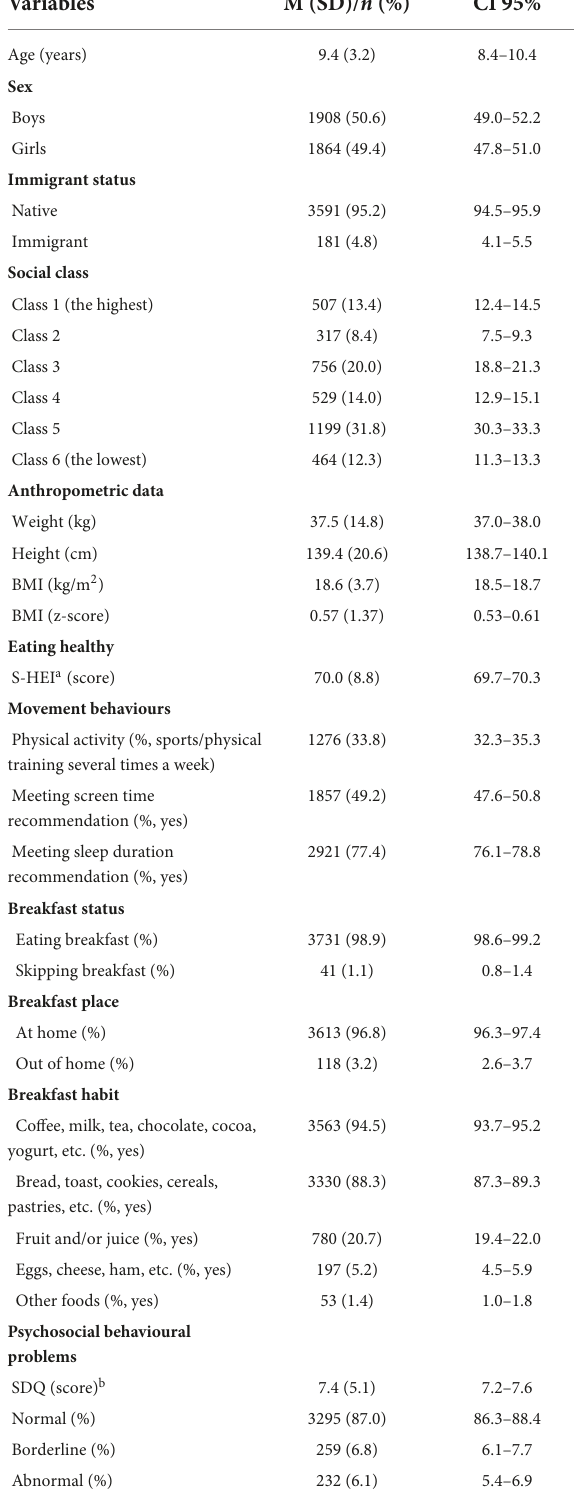
TABLE 1 Descriptive data of the study participants ( N =